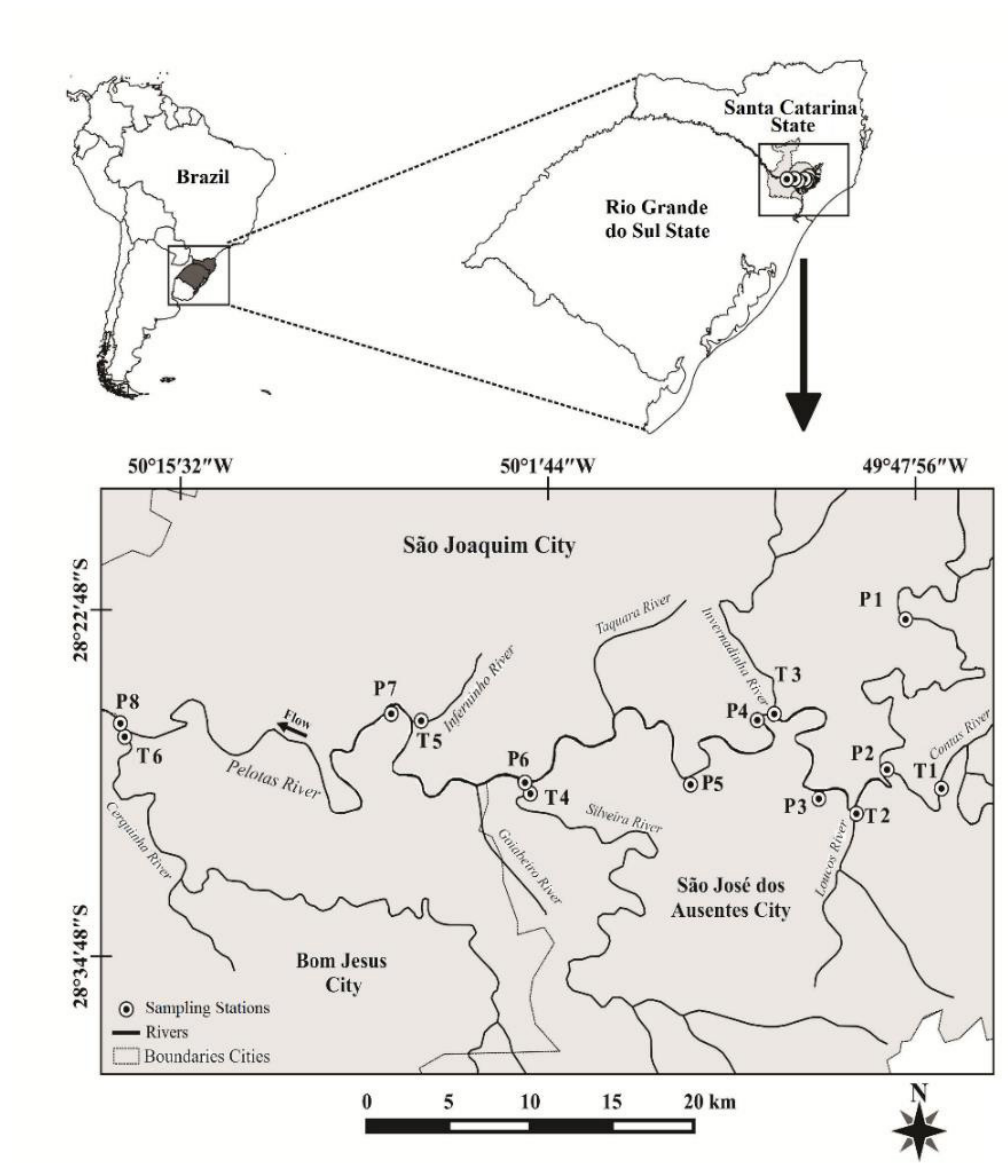
Figure 1. Study area and location of sampling sites in the Pelotas River sub-basin, states of Santa Catarina and Rio Grande do